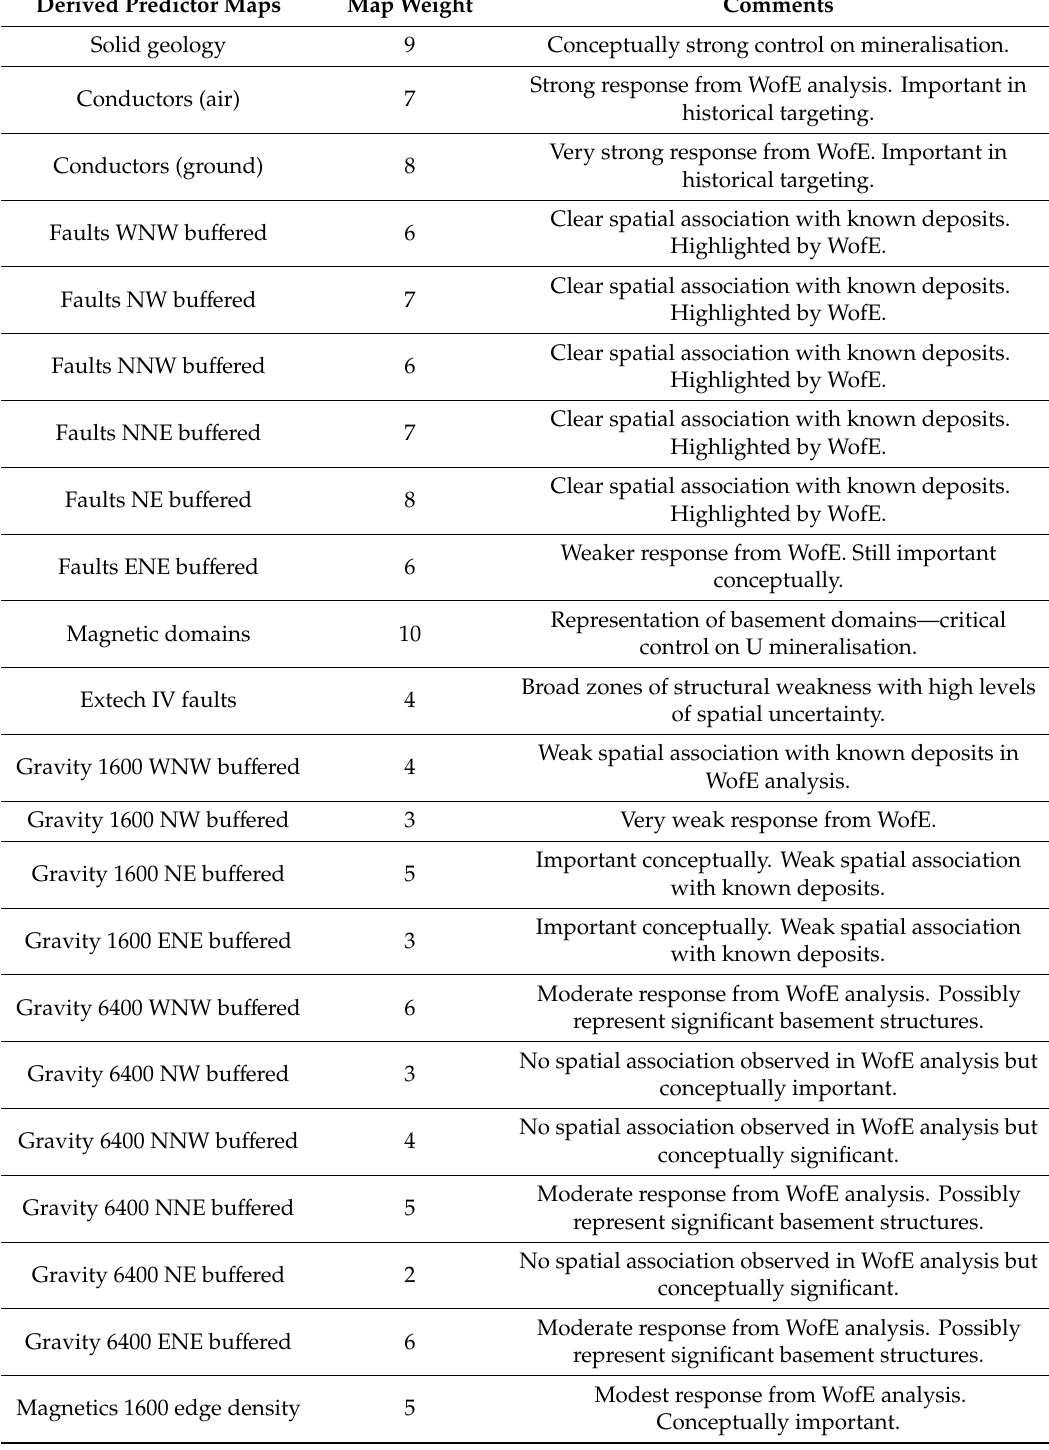
Table 7. Athabasca Basin MPM map weights. Weights reflect the perceived importance of the recognition criteria in the mineralisation model and / or greater confidence in the data from which the layer was derived. Full details, including class weights are provided in Appendix